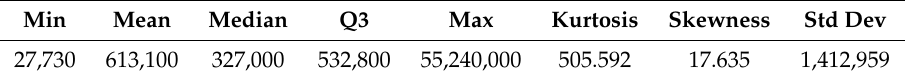
Table 1. Descriptive statistics of Danish empirical losses.